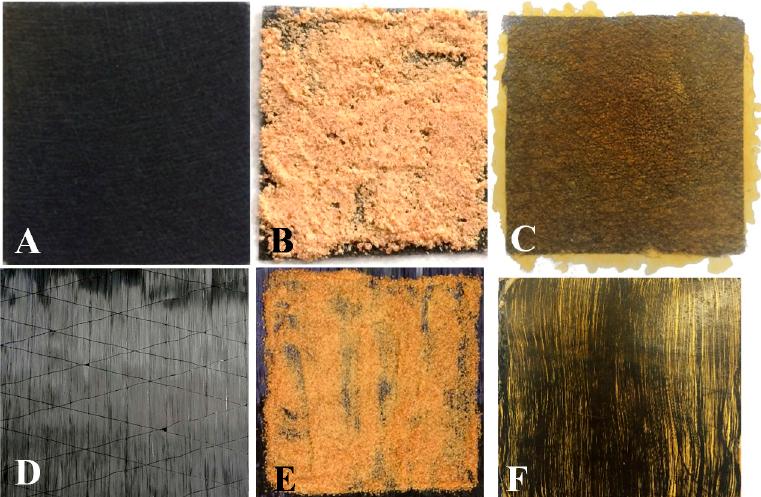
Figure 3. Steps of composites preparation: ( A ) Nonwoven mat, ( D ) unidirectional fibers covered with a layer of powdered DA polymer ( B , E ) and after compression molding ( C , F ).